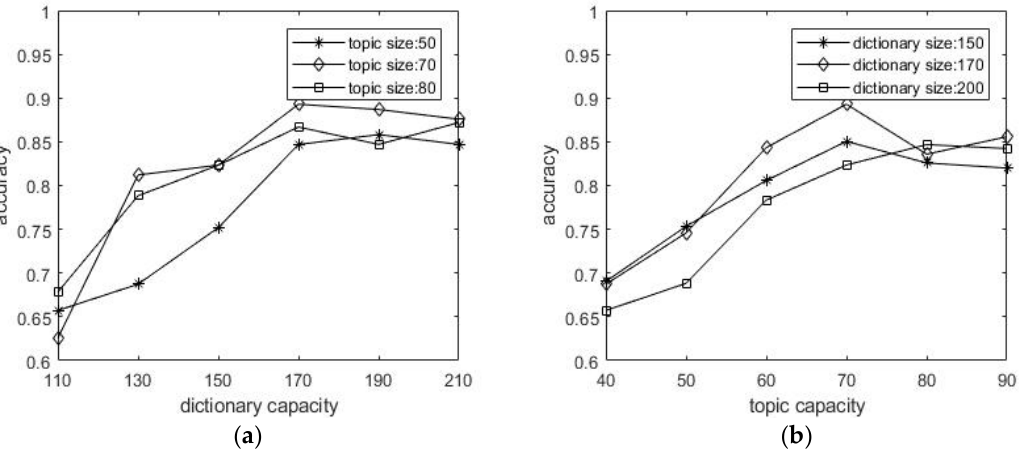
Figure 7. The Influence of dictionary capacity and topic capacity on the recognition accuracy. ( a ) Fixed the topic size and analyzed the influence of different dictionary capacity on the recognition accuracy. ( b ) Fixed the dictionary size and analyzed the influence of different topic capacity on the recognition accuracy.